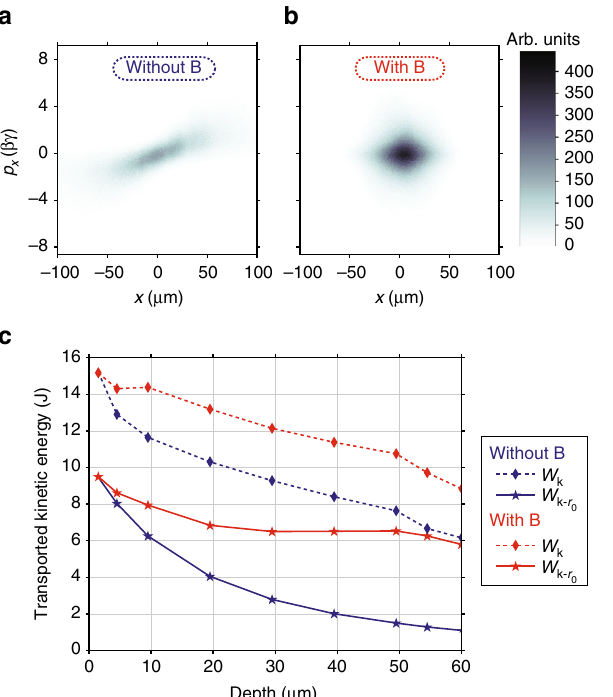
Fig. 4 Relativistic electron beam phase space and transported energy. a , b Relativistic electron beam (REB) transverse phase space ( x , p x ) at the target ’ s rear surface, a without imposed B- fi eld, b with imposed B- fi eld. c Transported energy as a function of the propagation depth into the target, with (red) and without (blue) imposed B- fi eld: total transported kinetic energy ( W k , diamonds) and its fraction within the initial REB radius r 0 centered on the target axis ( W k (cid:2) r , stars). All the plots correspond to the 0 transport-target in con fi guration (ii), positioned at the coil plane